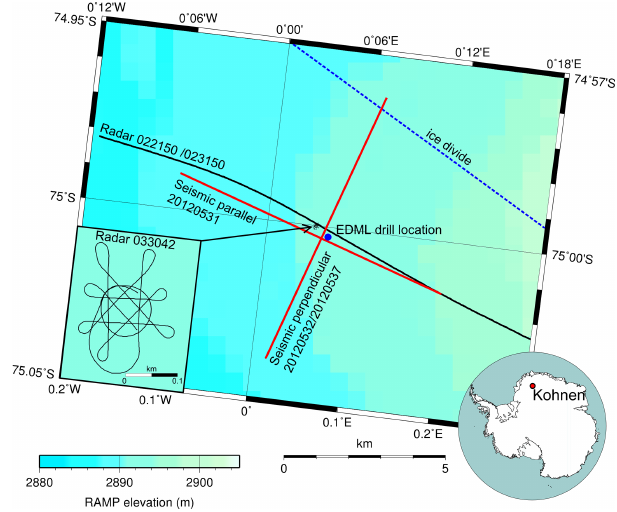
Figure 1. Different surveys carried out at Kohnen Station, Dron- ning Maud Land, Antarctica (inset of Antarctica “SCAR Antarctica Digital Database”). Geometry of seismic wide-angle survey car- ried out in January 2012 and 2013, with explosives and vibroseis as the source (red lines). Two lines were shot, one parallel (sur- vey 20120531) and one perpendicular (20120532/20120537) to the ice divide, respectively. The blue dot marks the drill location of the EDML ice core. The flight line of radar survey 022150 (600ns pulse) and 023150 (60ns pulse) is plotted in black. The inset shows survey 033042 (60ns pulse) done with the aircraft taxiing on the